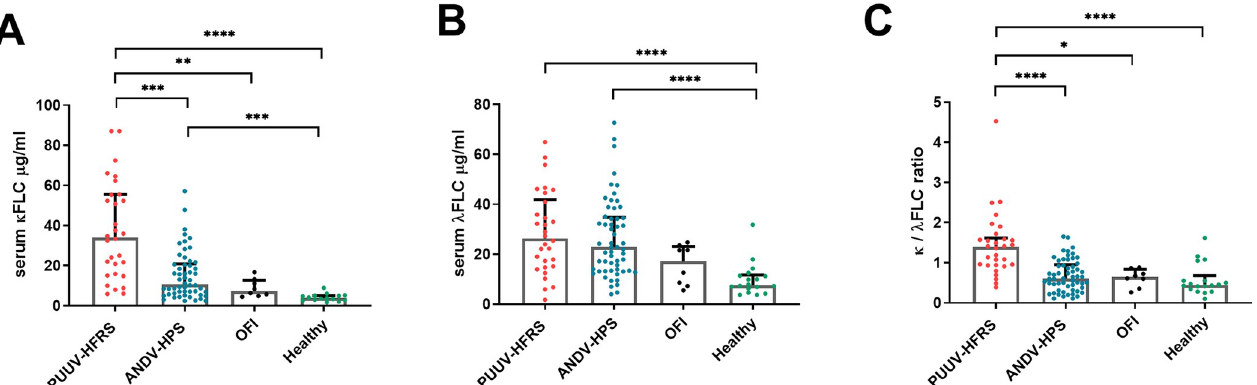
Fig 1. Soluble FLCs increase in hantavirus diseases. The concentrations of FLCs ( κ in A and λ in B ) as well as their ratio (in C ) were measured by ELISA from serum samples of acute PUUV-caused HFRS (n = 30), ANDV-caused HPS (n = 50), other febrile illness (OFI; n = 8) and healthy volunteers (n = 18). The medians of patients with acute PUUV infection and OFI were compared to medians of healthy volunteers by Kruskal-Wallis + Dunn’s multiple comparisons test and significant differences reported as � = p < 0.05, �� = p < 0.01, ��� = p < 0.001 and ���� = p < 0.0001. The bars indicate medians + interquartile ranges.